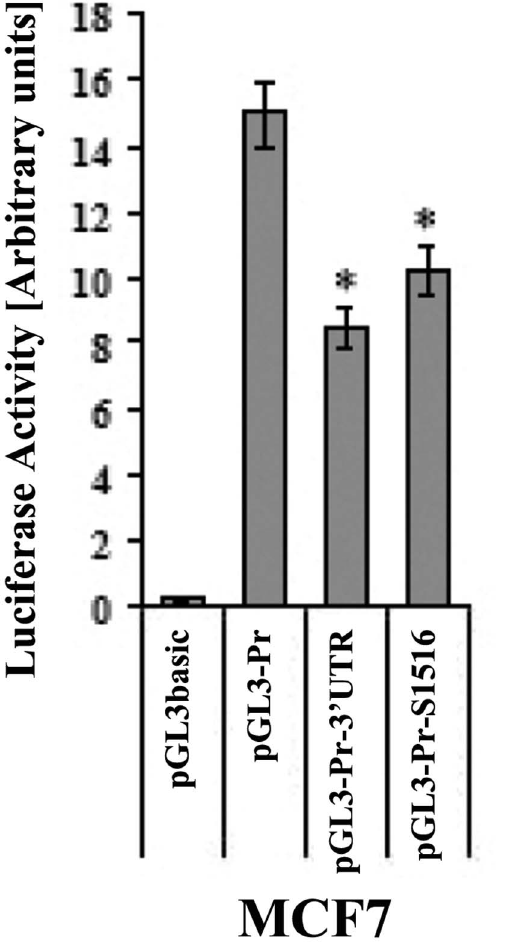
Figure 4. 3 9 UTR and 5 9 UTR-driven effects in MCF7 breast cancer cells. Luciferase assay in MCF7 cells transfected with different constructs including the pGL3 control, the pGL3-Pr, in addition to the full length 3 9 untranslated region (pGL3-Pr-3 9 UTR) or the S1516 regulatory element (pGL3-Pr-S1516). The experiments were performed at least three times in quadruplicates (* p ,